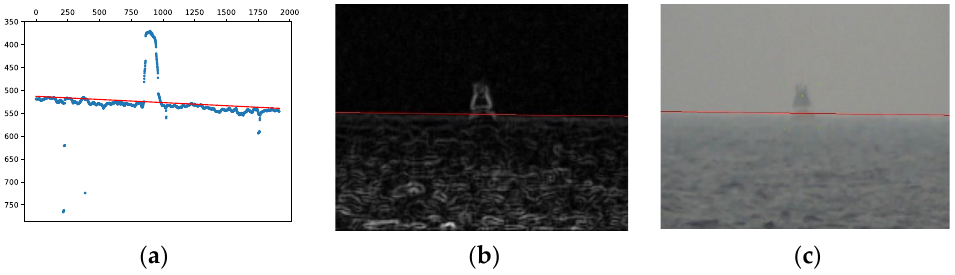
Figure 9. Image results of sea-sky line extraction: ( a ) scatter fitting result; ( b ) sea-sky line extraction result of the image after edge detection; ( c ) sea-sky line extraction result of the original image.